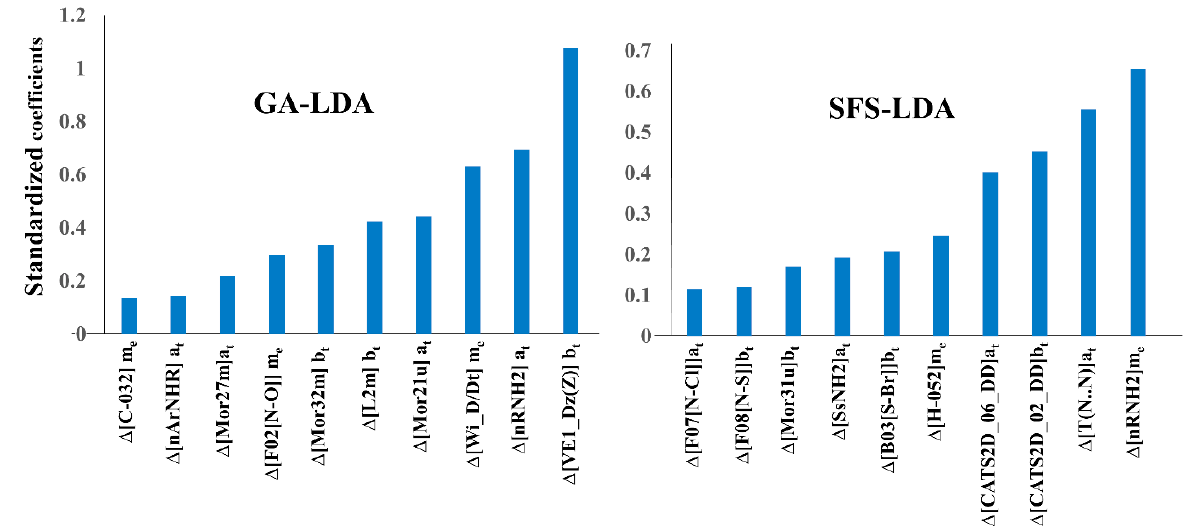
Figure 3. Absolute standardized coefficients vs. variables in the mt ‐ QSAR models.